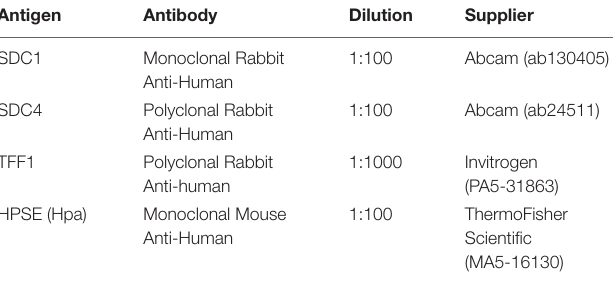
TABLE 3 | Primary antibodies used in this study for